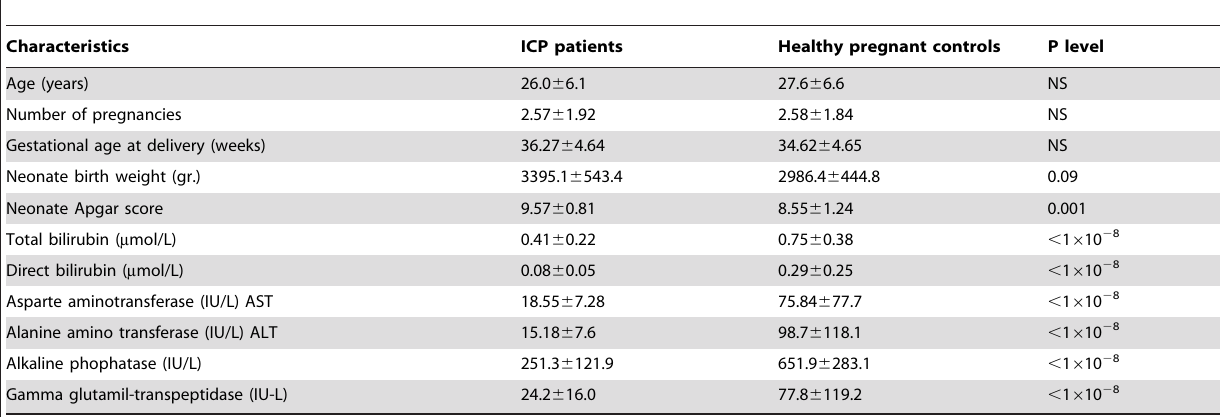
Table 1. Clinical, biochemical, obstetrical, and perinatal characteristics of patients with intrahepatic cholestasis of pregnancy (ICP) and healthy pregnant women.